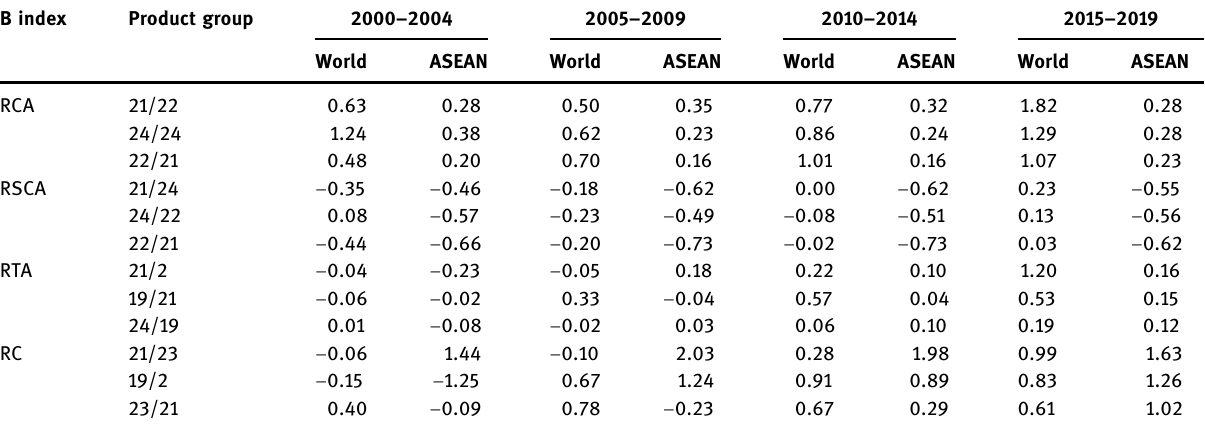
Table 11: The three highest Balassa indices of Singapore at World and ASEAN level, 2000 –